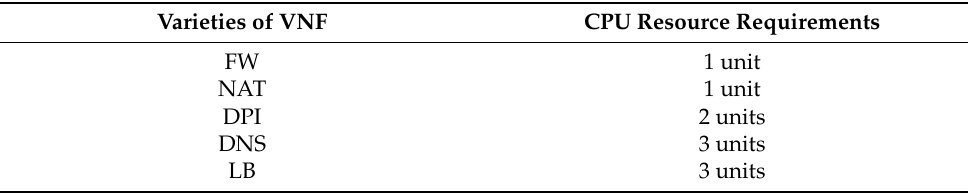
Table 2. All VNFs and their respective CPU resource requirements.